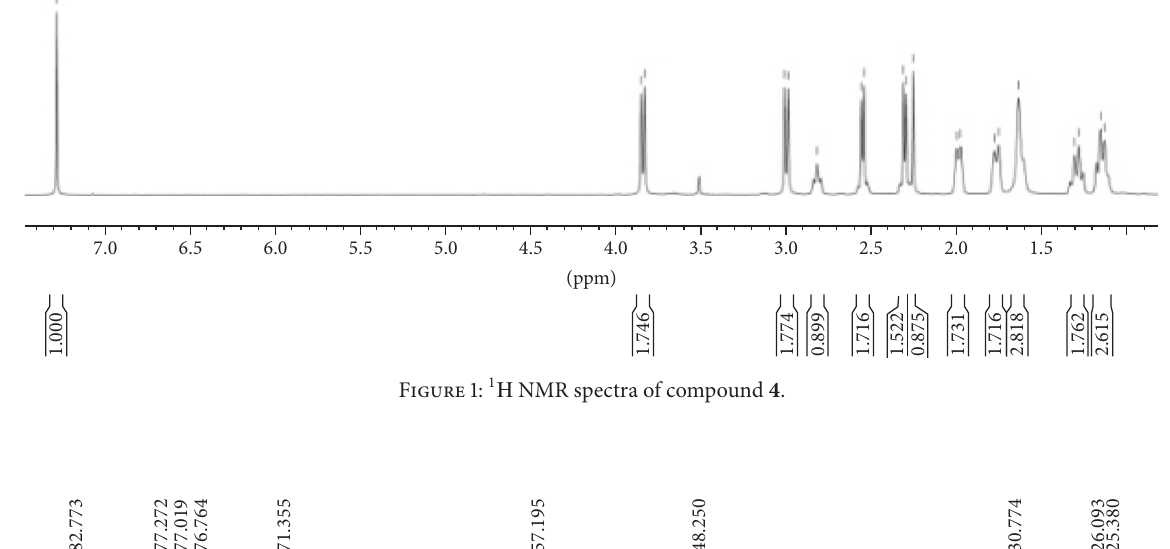
Figure 1: 1 X NMR spectra of compound 4 .